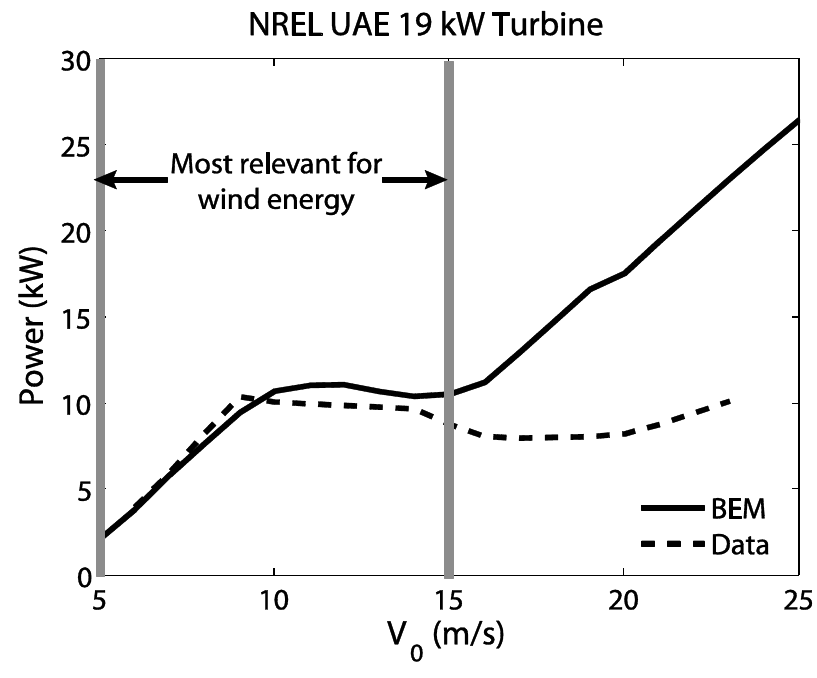
Figure 2. NREL power comparison as a function of incoming wind speed, V lines indicate the range of wind speeds that are relevant for wind energy production.